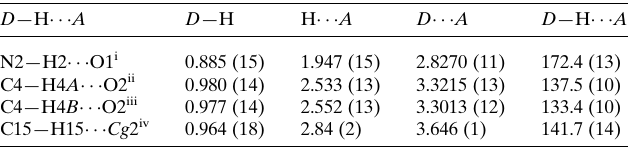
Table 1 Hydrogen-bond geometry (A˚ , (cid:2) ). Cg 2 is the centroid of the C6–C11 phenyl ring.